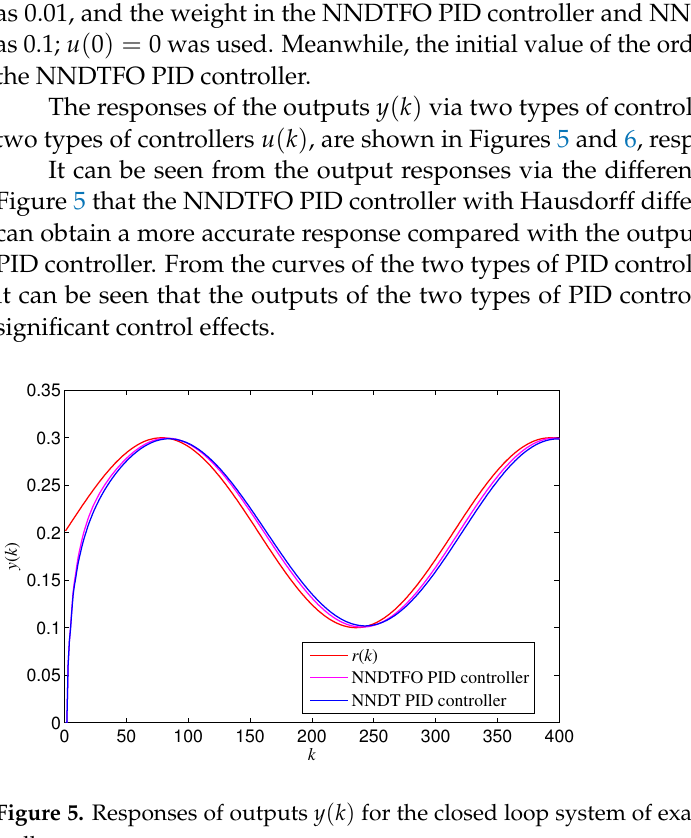
Figure 5. Responses of outputs y ( k ) for the closed loop system of example 1 via two types of con- troller.